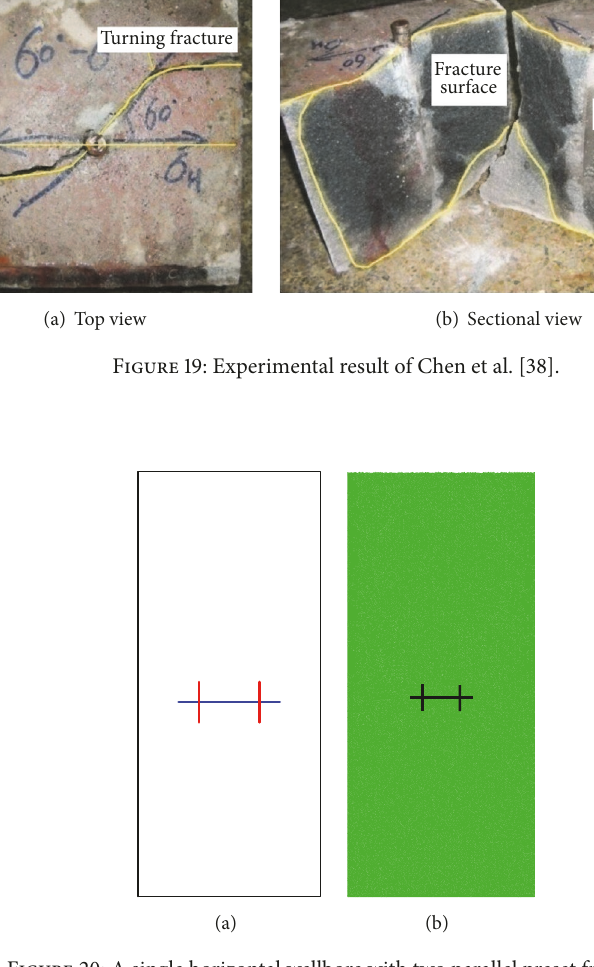
Figure 20: A single horizontal wellbore with two parallel preset